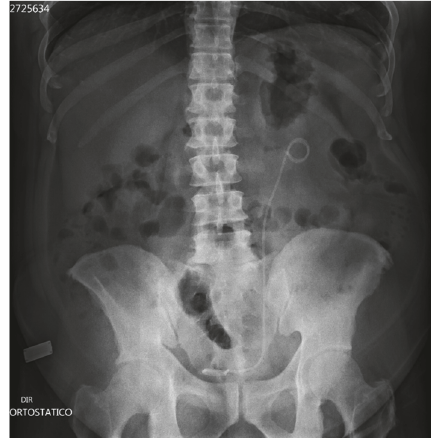
Figure 2: Abdominal X-ray showing absence of residual calculi in left pyelocalicial